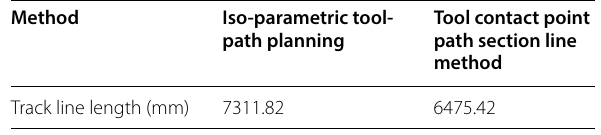
Table 4 Comparison of a key parameter of the